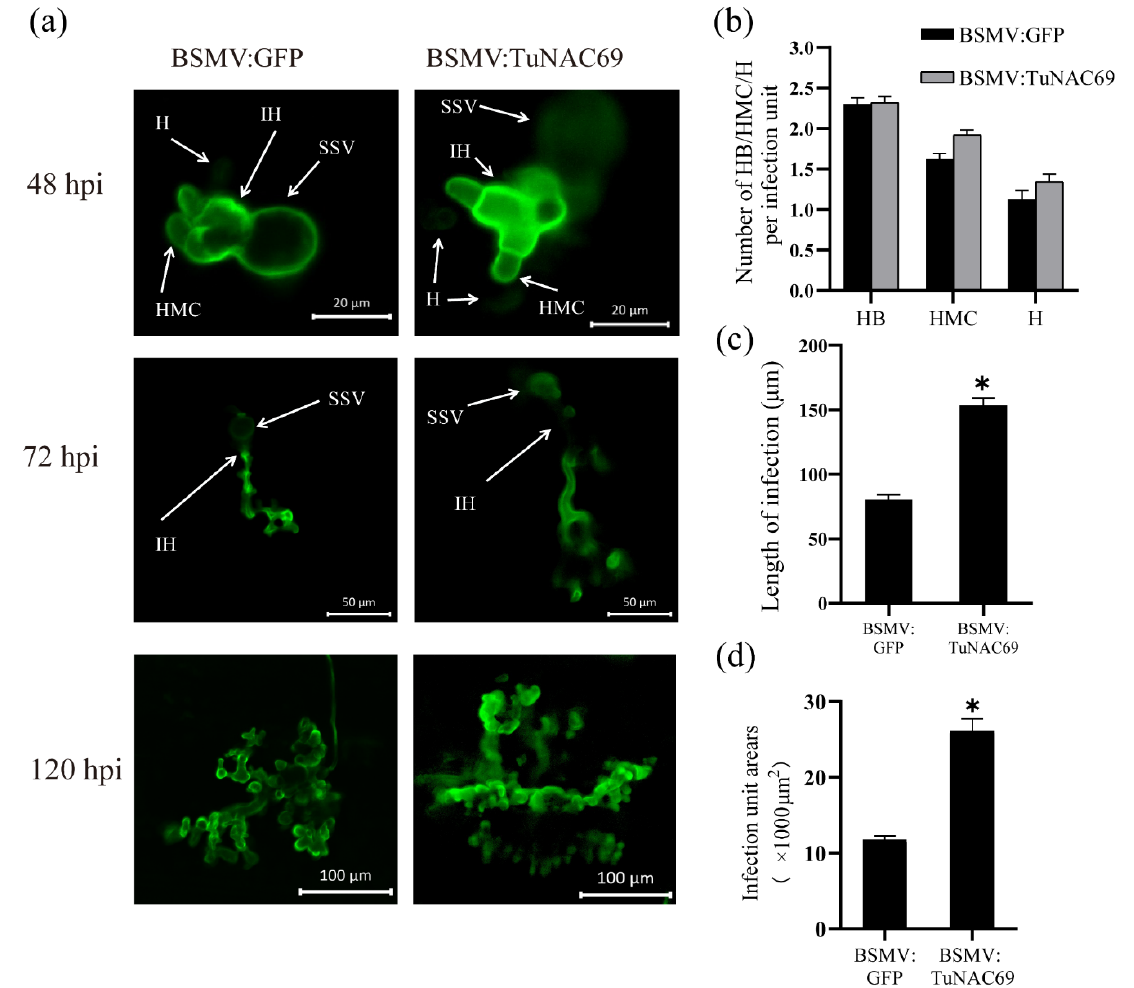
Figure 6. Histological observation of Pst . ( a ) The morphology of mycelium was observed by WGA staining at 48 hpi, 72 hpi and 120 hpi. The Bar is 20 μ m, 50 μ m or 100 μ m, as indicated. ( b ) The numbers of HB, HMC and H of Pst in each infected site were counted and the average was calculated, and there was no significant difference at 48 hpi. ( c ) The length of IH in each infected site was measured at 72 hpi. ( d ) The area of each infected site of 120 hpi inoculated with stripe rust. The mycelium length and extended infection area in BSMV: TuNAC69 plants were measured. Values represent the mean ± SE of three independent samples ( n = 50). Statistically significant difference (Student’s t ‐ test): *, p < 0.05.